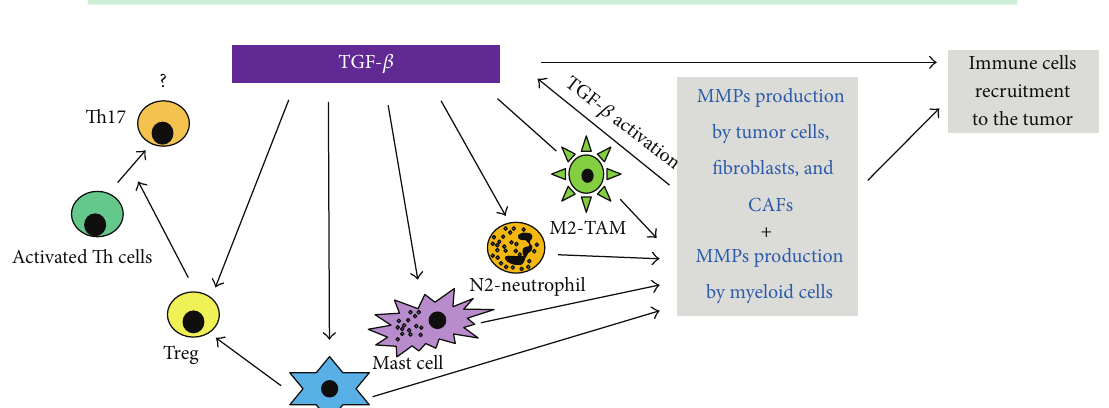
and (5) suppression of macrophages, dendritic cells (DCs), and natural killer (NK)